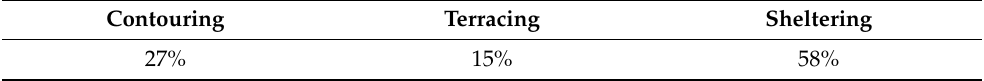
Table 6. Ratio (in percentage) of conservation practice in Cameron Highlands district [23].